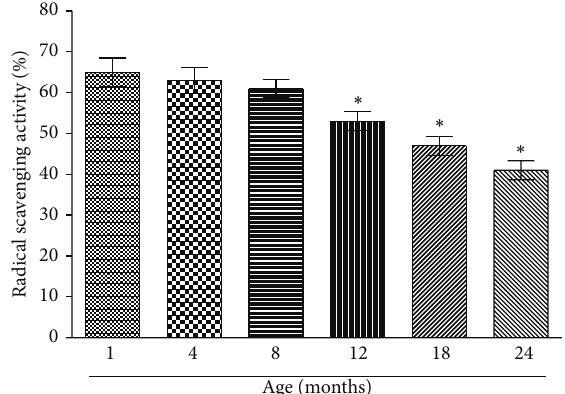
Figure 3: Plasma malondialdehyde (MDA) content as a function of age of rats (in months). MDA level is expressed as nmol ⋅ mL −1 of plasma. Values are mean ± SEM. ∗ 𝑃 < 0.001 compared to control (1-month-old rat).